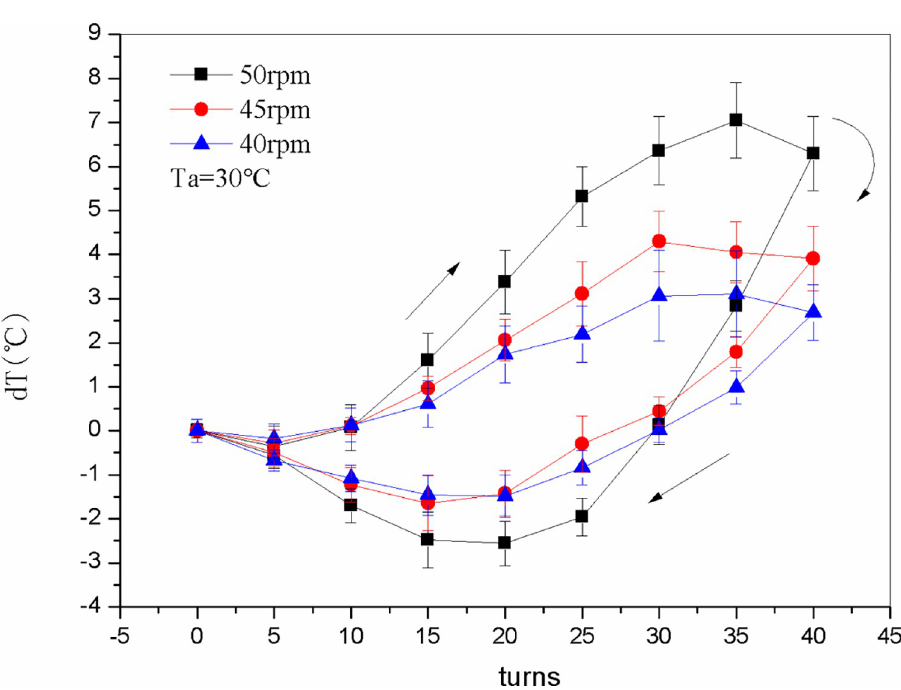
Fig 9. Temperature difference between the surface of a two-nitinol-wire combination and ambient air ( dT ) as a function of the stepping motor speed ( n ). 1